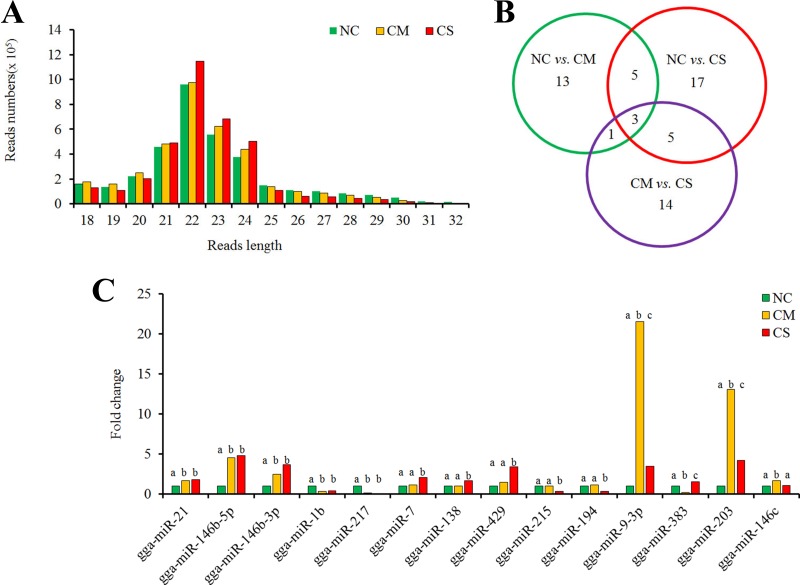
Different expression profiles of miRNAs among the NC, CM, and CS groups. (A) Size distribution of sequenced small-RNA reads. (B) Venn diagram demonstrates the overlap of differently expressed miRNAs among each group. Numbers in each section indicate the numbers of differently expressed miRNAs in the comparison. (C) The expression profiles of overlapped miRNAs with a significant change in at least two groups (P value <0.01, fold change >1.5). Different letters (a, b, and c) indicate statistically significant differences at a P value of <0.01. Only three miRNAs (gga-miR-383, gga-miR-203, and gga-miR-9-3p) were significantly differently expressed in each group. NC, nonchallenged control; CM, challenged, mild pathology; CS, challenged, severe pathology.